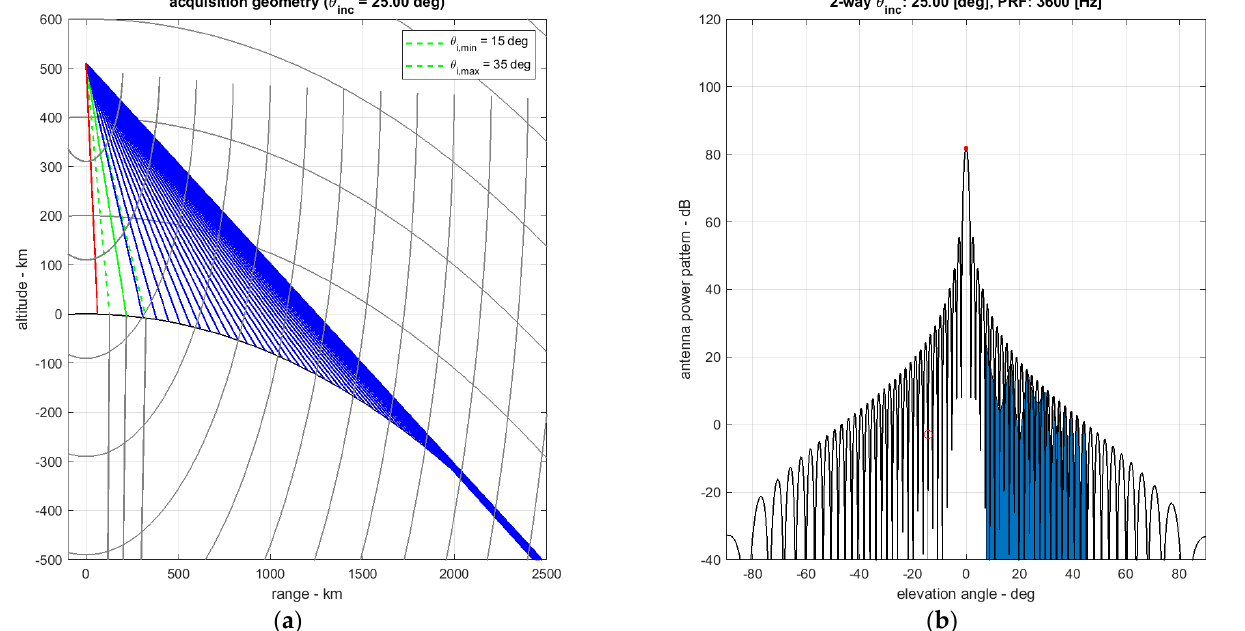
Figure 27. ( a ) Forward range ambiguities (blue), backward range ambiguities (red), and antenna beam boresight (green), and ( b ) range ambiguities in the elevation angle.